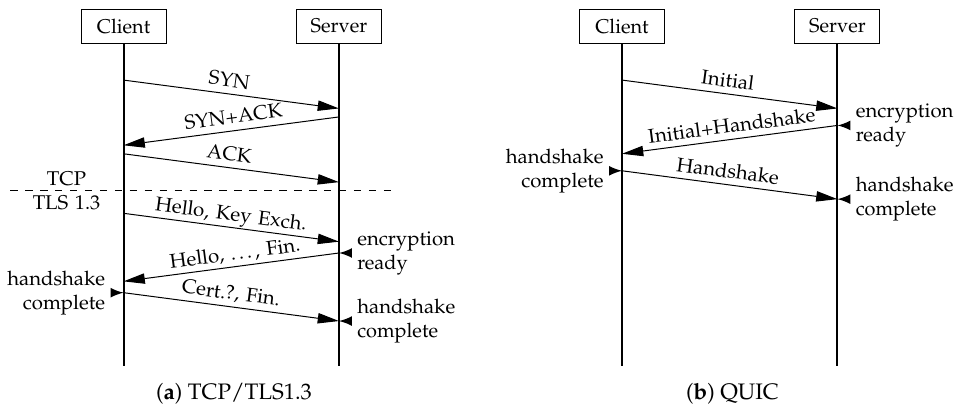
Figure 2. Establishment of TCP ( a ) and QUIC ( b ) with version 1.3